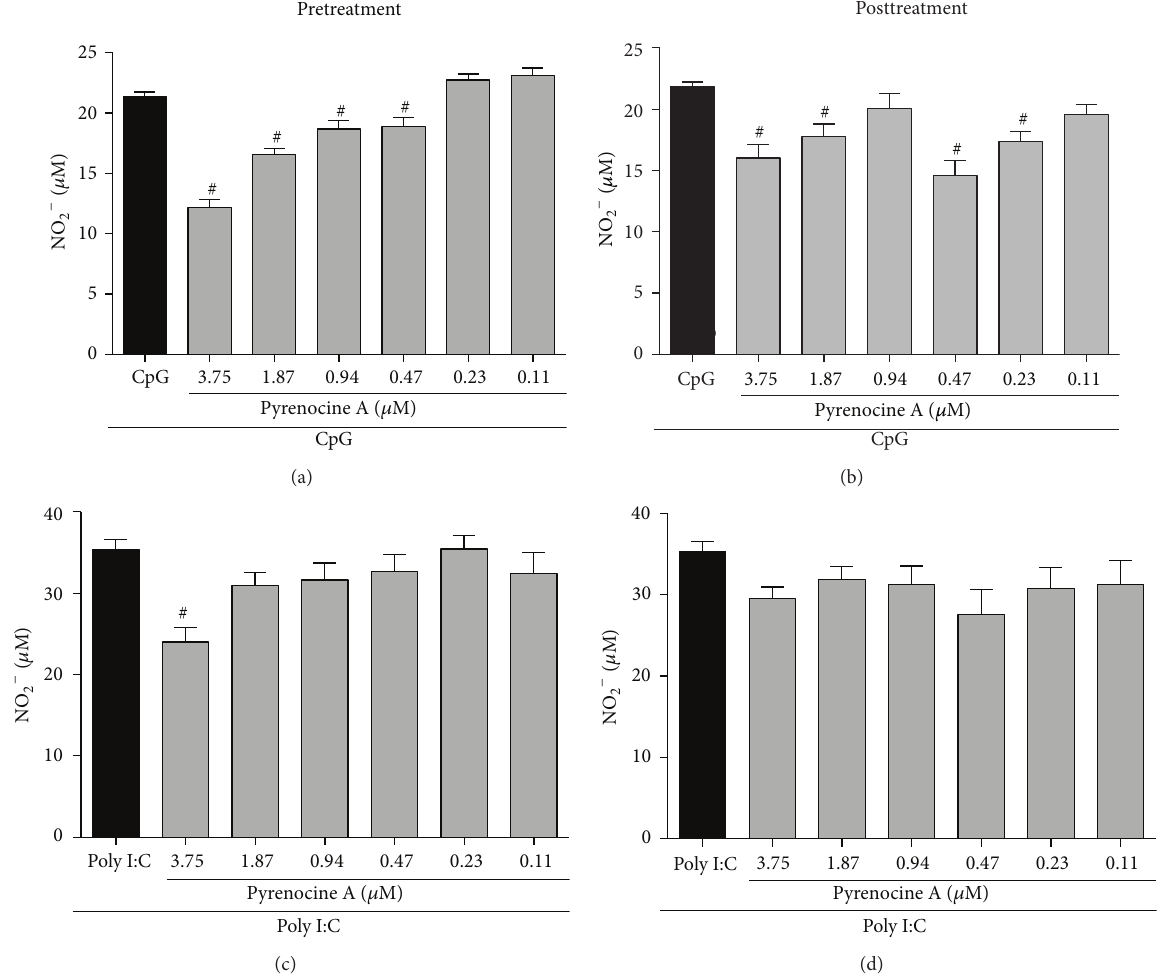
Figure 6: Anti-inflammatory effects of pyrenocine A by TLR9/MyD88 pathway. Pretreatment procedure: cells were pretreated with different concentrations of pyrenocine A (3.75–0.11 𝜇 M) for 2 h and then stimulated with CpG (1 𝜇 g/mL) during 18h (a) or Poly I:C (1 𝜇 g/mL) (c). Posttreatment procedure: cells were stimulated with CpG (1 𝜇 g/mL) (b) or Poly I:C (1 𝜇 g/mL) (d) for 2h and then pyrenocine A (3.75– 0.11 𝜇 M) was added during 18 h. The supernatants were collected to quantify NO. Results correspond to the mean ± SEM of three independent experiments performed in quintuplicate for each condition. # 𝑃 < 0.05 versus CpG or Poly I:C alone